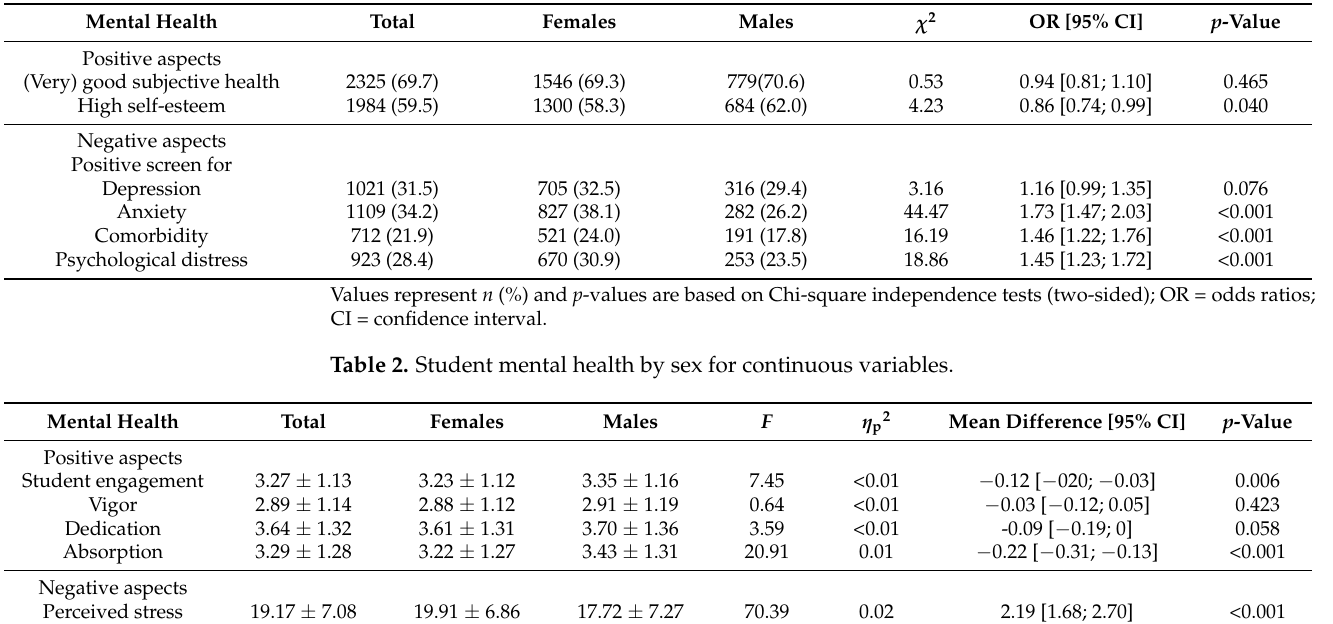
Table 1. Student mental health by sex for categorical variables.